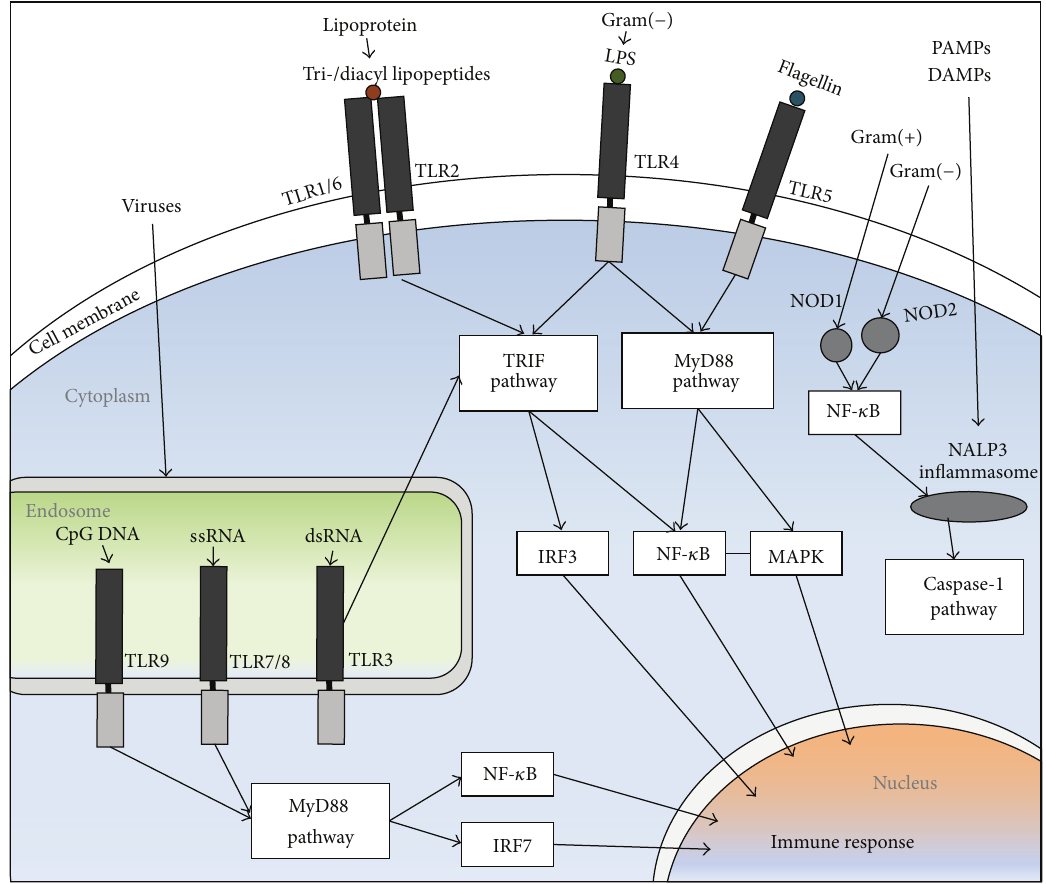
Figure 1: Schematic overview of TLR and NLR signaling pathways. PAMPs and DAMPs are recognized by PRRs. Heterodimer of TLR1/6+TLR2, TLR4, and endosomal TLR3 activate TRIF pathway, followed by induction of IRF and NF- 𝜅 B. TLR5 and endosomal TLR9 and TLR7 activate MyD88 pathway, followed by activation of MAPK, NF- 𝜅 B, and IRF7. NOD1 and NOD2 are cytoplasmic PRRs, and they trigger NF- 𝜅 B, and NALP3 inflammasome recruits and activates caspase-1 pathway. DAMP: damage-associated molecular patterns; IRF: IFN-regulatory factor; MAPK; mitogen-activated protein kinase; MyD88; myeloid differentiation primary-response gene 88; NF- 𝜅 B: nuclear factor- 𝜅 B; NALP3: NACHT, LRR, and pyrin domain containing protein 3; NOD: nucleotide-binding oligomerization domain; NLR: NOD- like receptor; PAMP: pathogen-associated molecular patterns; TLR: Toll-like receptor; TRIF: Toll/IL-1R (TIR) domain containing adaptor protein inducing IFN- 𝛽